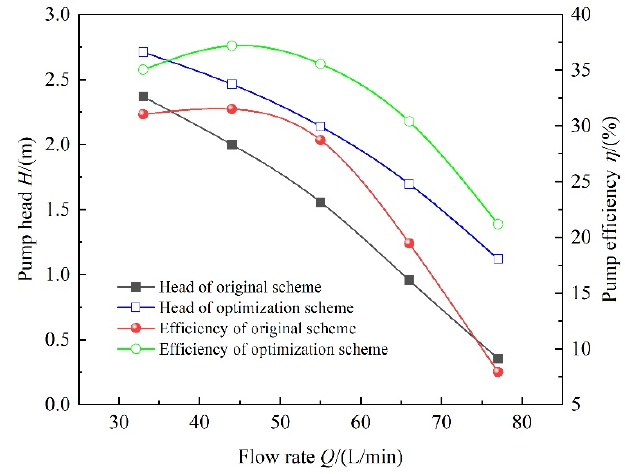
Figure 10. Hydraulic performance of the new type of dishwasher pump before and after optimization.